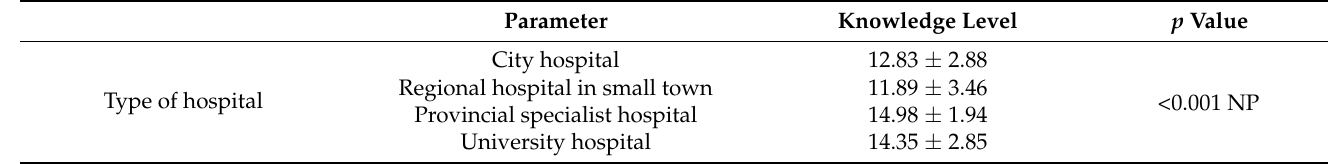
Table 3. Analysis of correlations between selected sociodemographic variables and the level of knowl- edge related to score of the Nurses’ Knowledge of Heart Failure Education Principles